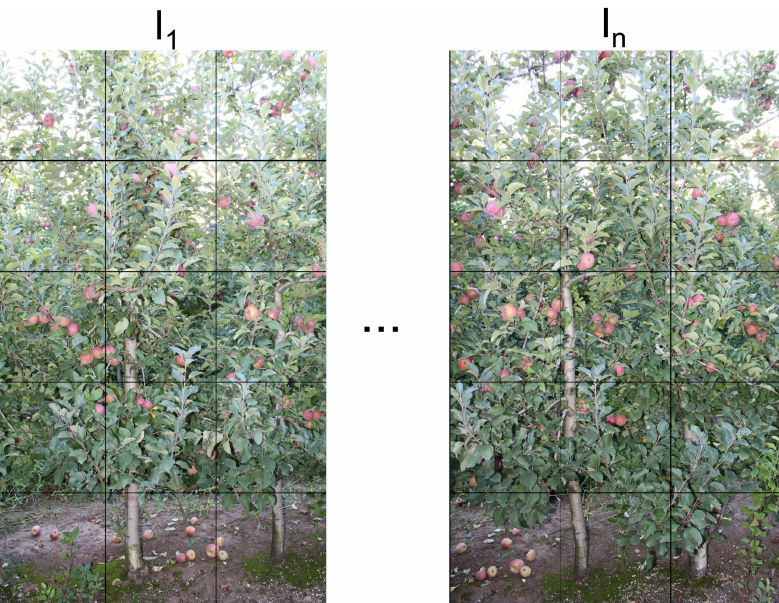
Figure 4. Example of two images and their division into non-overlapping patches.